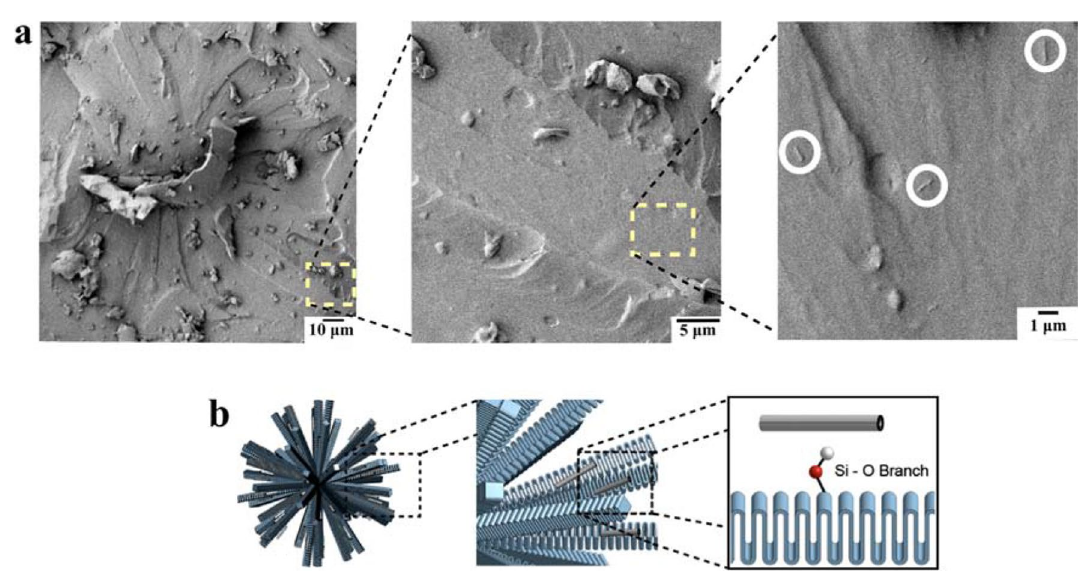
Figure 5. (a) FESEM images of spherulitic texture in the nanocomposite showing evidence of HNT positioning in the lamellar crystal bundle (circled in white) and (b) schematic representation of the spherulitic structure in the nanocomposite showing the bonding of hard segment chains with silane terminations to HNTs. (b) Created by Anton Lebar and used with